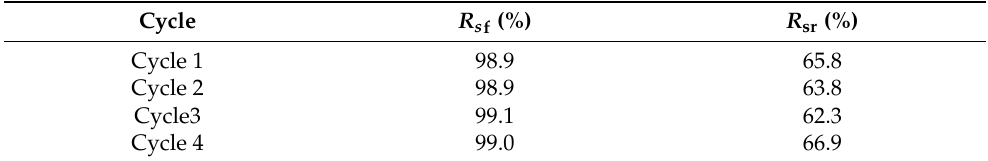
Table 6. Shape fixation and recovery ratios ( R sf and R sr ) in a continuous dual-shape-memory process. Cycle R s f (%)